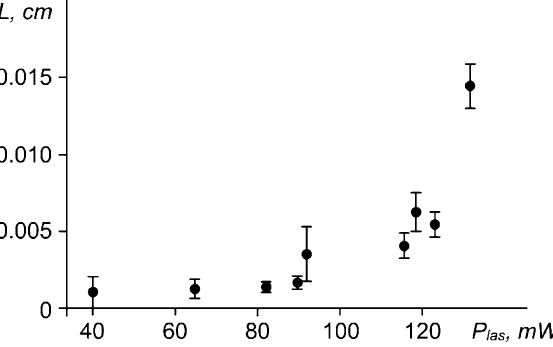
Figure 7. Dependence of the persistence length L of the moving grains on the laser power P las